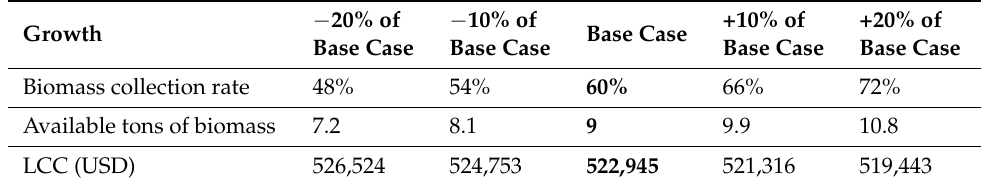
Table 15. Optimal configuration results with the variation of biomass collection rate.